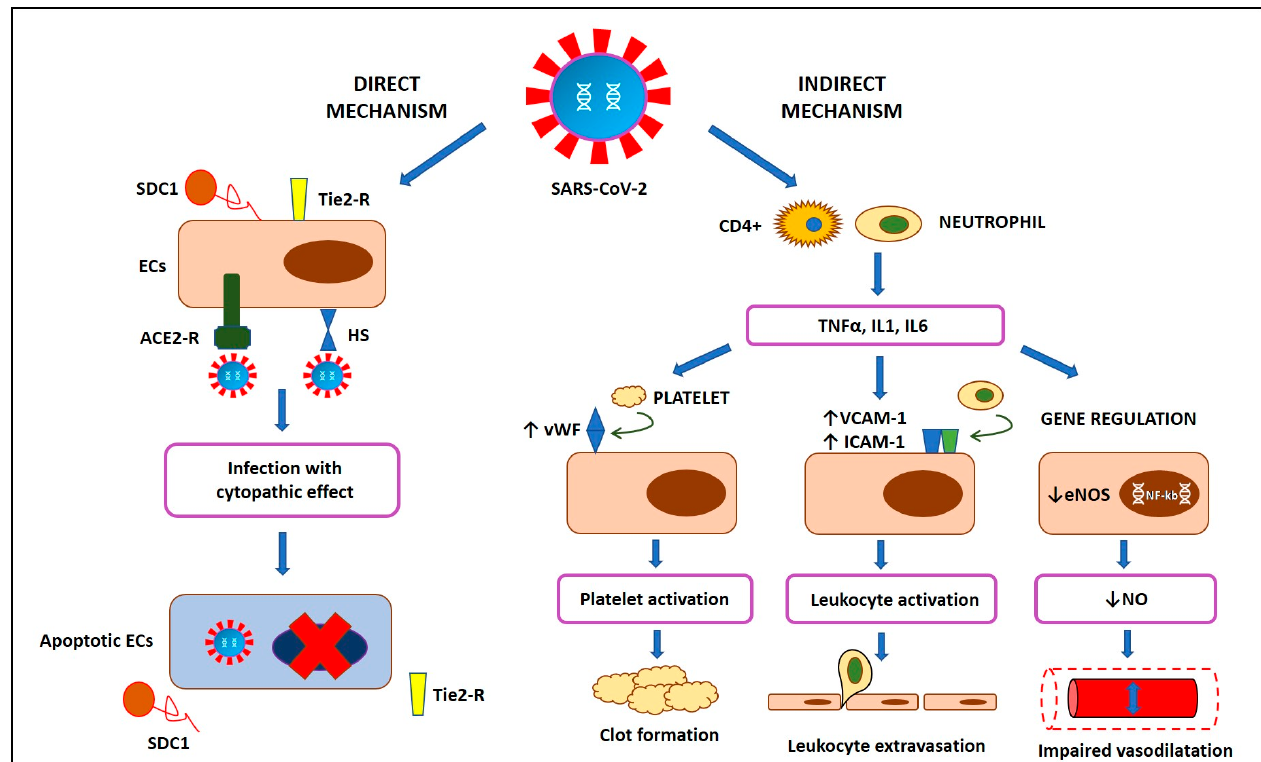
Figure 4. Physiopathology of endothelial dysfunction in coronavirus disease 2019 (COVID-19). SARS-CoV-2: severe acute respiratory syndrome coronavirus 2; ECs: endothelial cells; ACE2-R: angiotensin converting enzyme 2 receptor; HS: heparan sulphate; SDC1: syndecan-1; CD4+: cluster of differentiation 4 cells; TNF α : tumor necrosis factor α ; IL1: interleukin 1; IL6: interleukin 6; vWF: von Willebrand factor; VCAM-1: vascular cell adhesion molecule-1; ICAM-1: intercellular adhesion molecule-1; eNOS: endothelial nitric oxide synthase; NF- κ B: nuclear factor- κ B; NO: nitric oxide.